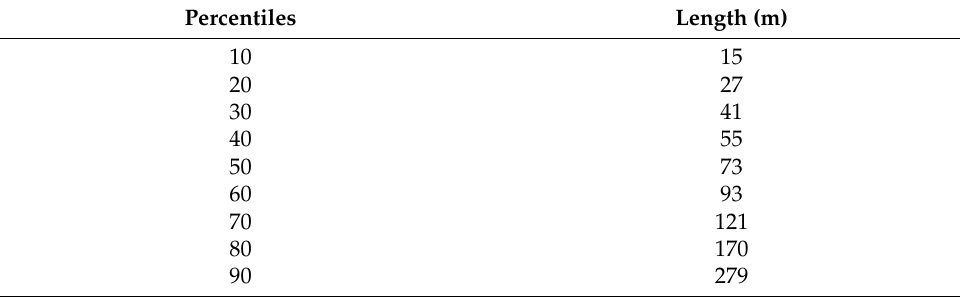
Table 1. Threshold values for different link length